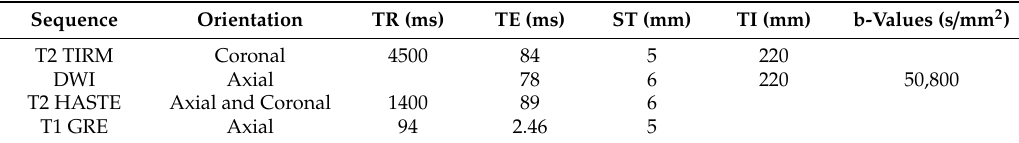
Table 2. Scan parameters for whole-body